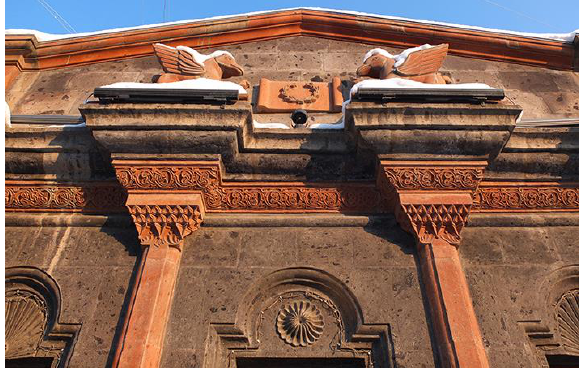
Figure 12. Fragment of Gyumri's vernacular ensemble: red tuff ornaments on the black tuff building facade on Jivani Street.